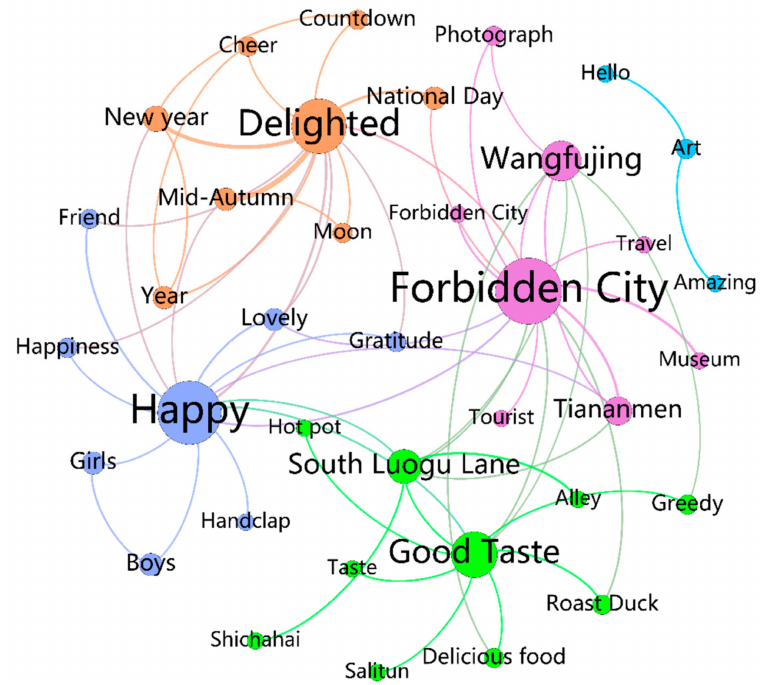
Figure A5. The positive sentiment profile of flows linked to attractions in the